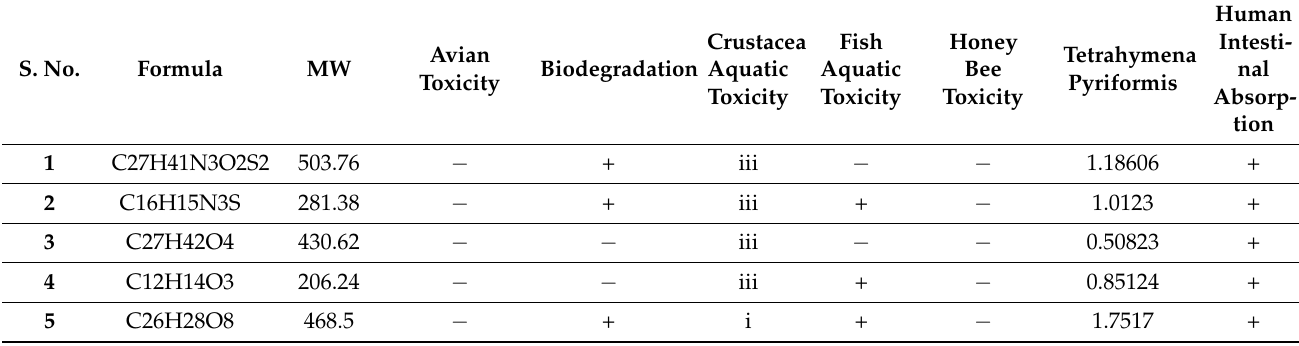
Table 3. Shortlisted compounds with their drug parameters and toxicity report.